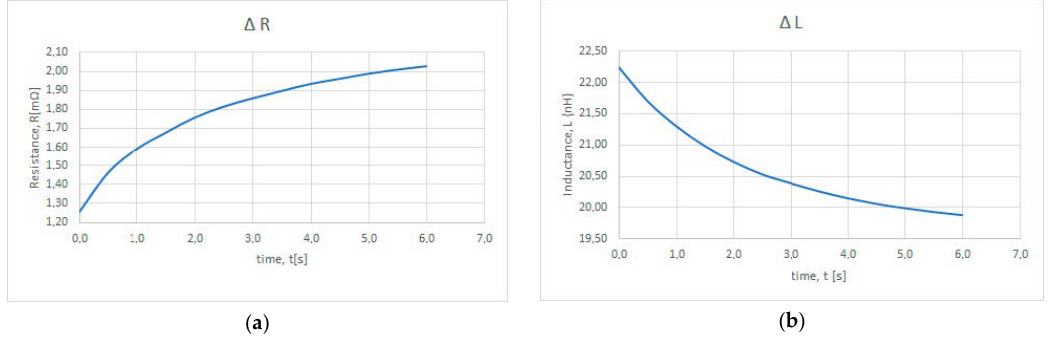
Figure 14. Δ R ( a ) and Δ L ( b ) as a function of time.